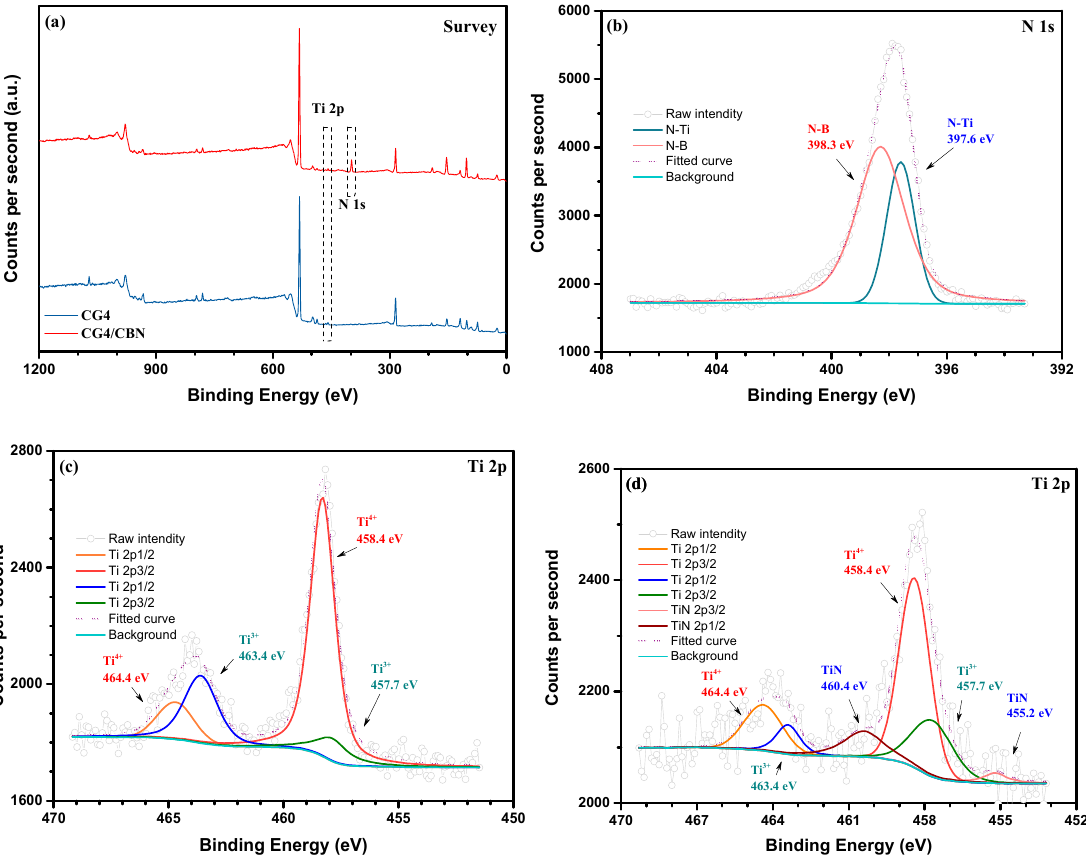
Figure 14. XPS spectrum of the TC composite. ( a ) survey of TC4 and TC4/CBN composite, ( b ) N 1 s of TC4/CBN composite, ( c ) Ti 2p of the matrix added 4 wt% TC alloy, ( d ) Ti 2p of TC4/CBN